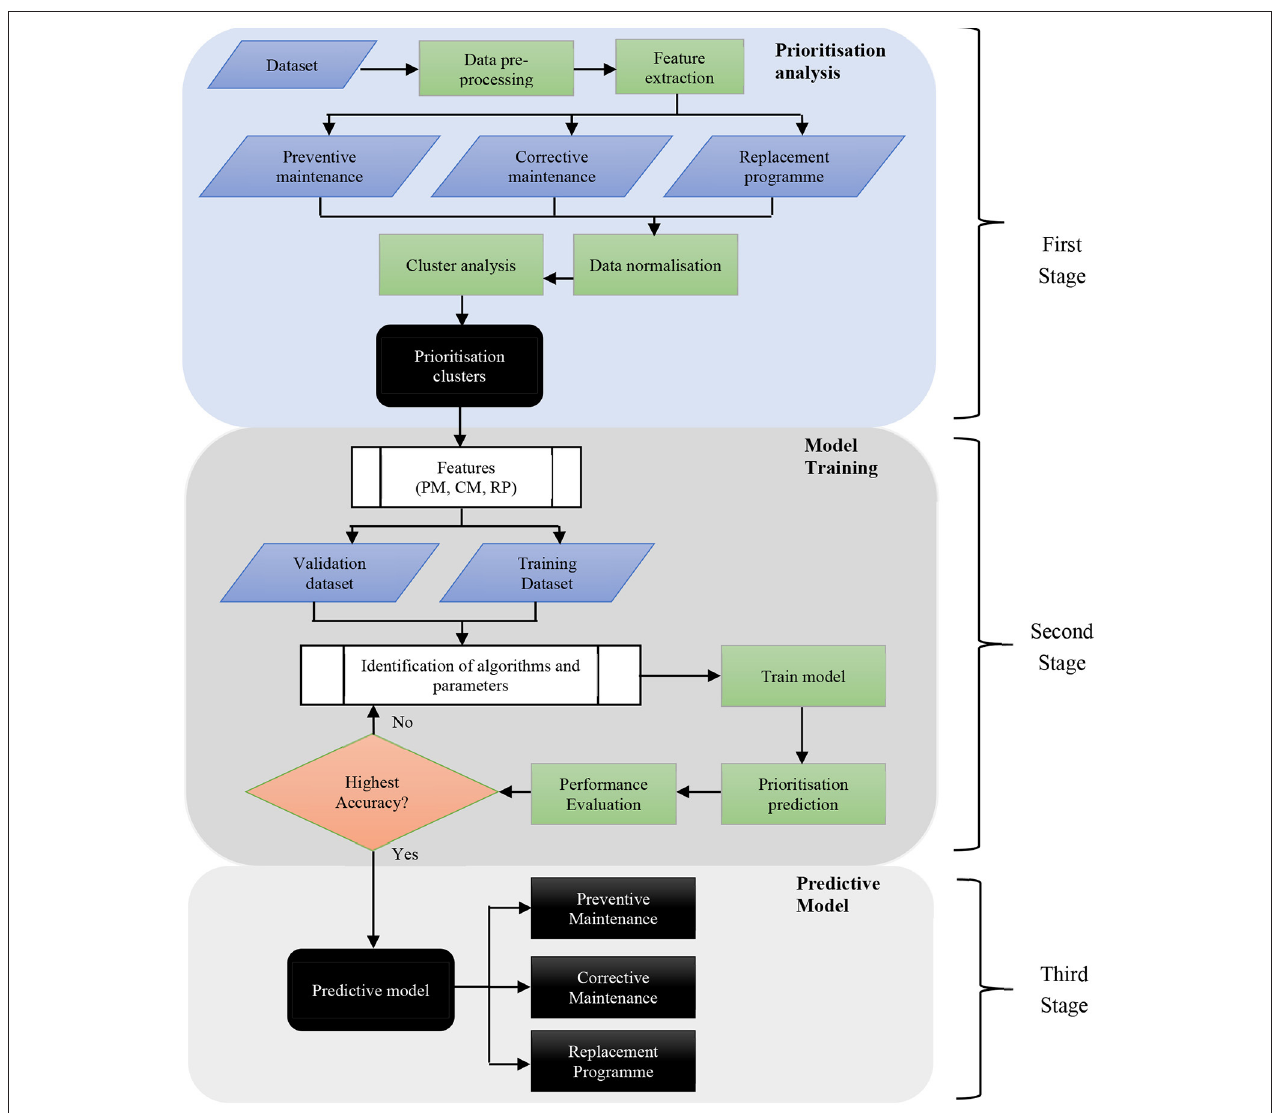
FIGURE 1 | The block diagram of the prioritisation assessment and medical equipment development prediction